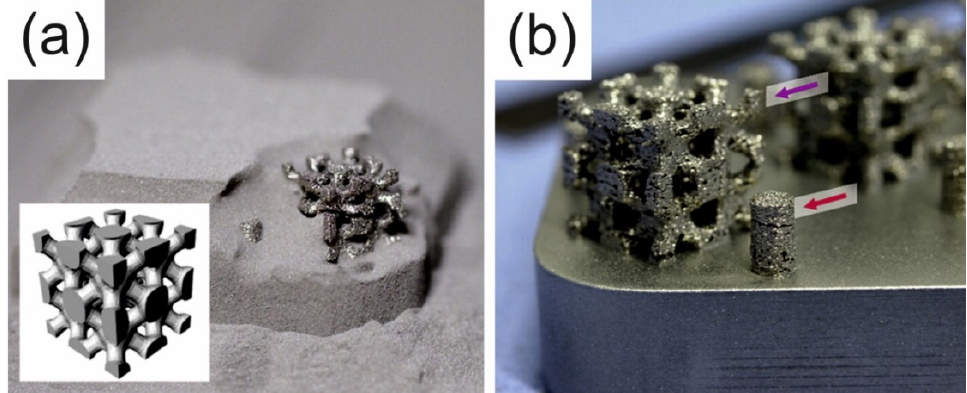
Figure 15. Fe-based BMG parts fabricated via LPBF ( a ) inside the LPBF machine and ( b ) after removing the remaining powder. Modified from [43], with permission from Elsevier, 2021.